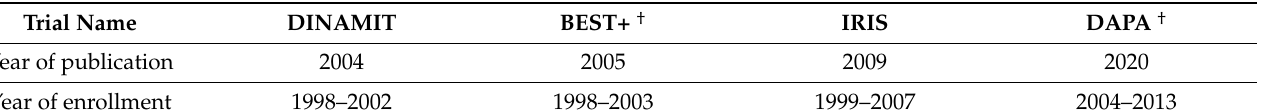
Table 2. Early ICD implantation trials for primary prevention of SCD after acute